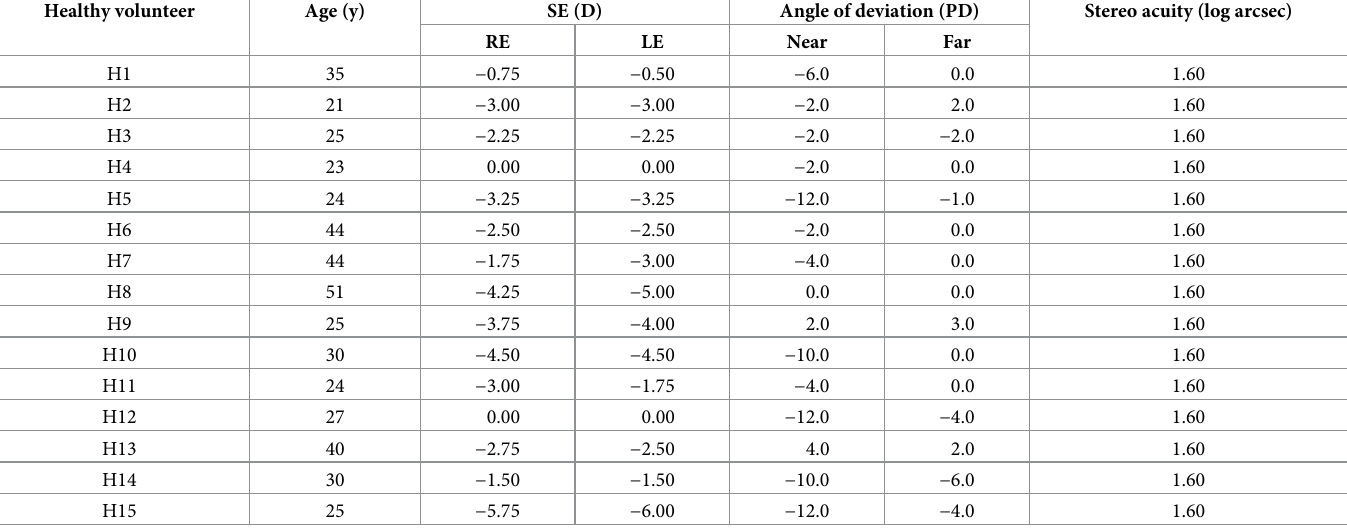
Table 2. Demographics of the control group.